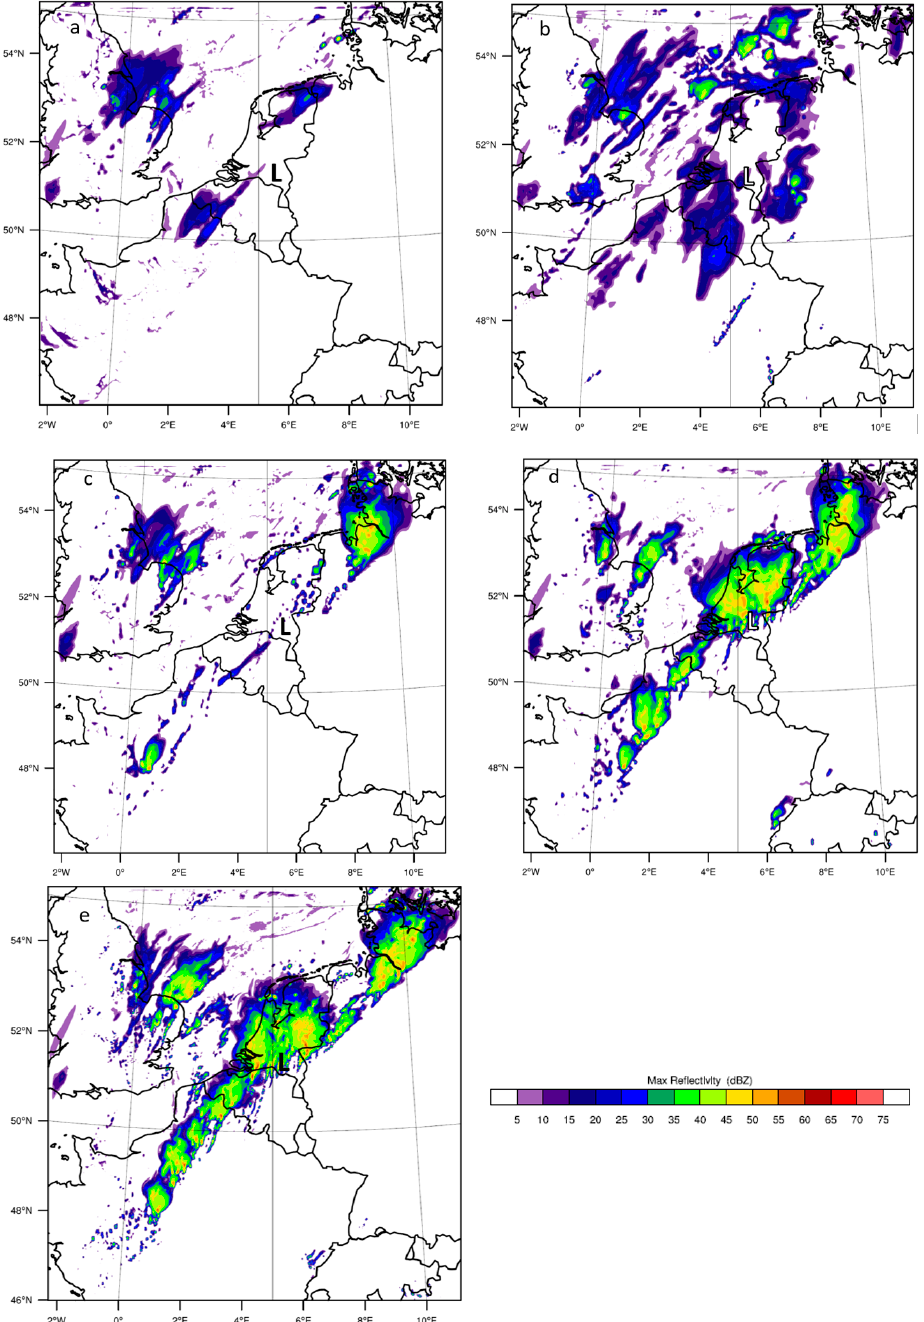
Figure 4. Modelled max reflectivity (dBZ) on 23 June 2016 at 18:00 UTC. ( a ) Kain–Fritsch; ( b ) Betts–Miller–Janjic; ( c ) Grell–Freitas ensemble. ( d ) Explicit 4 km; ( e ) explicit 2 km. L indicates Luyksgestel.